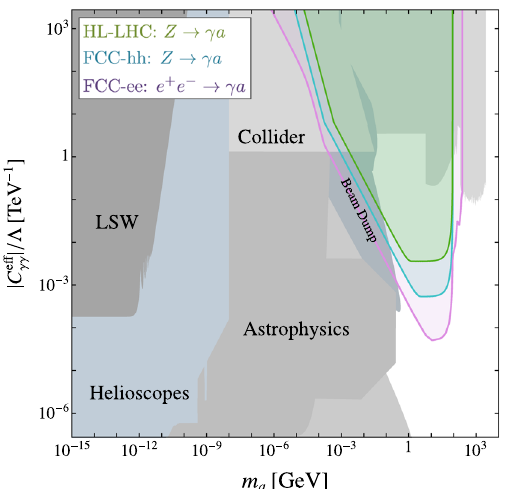
Fig. 12.5 Parameter regions which can be probed in the decay Z → γ a with a → γγ by the HL-LHC, FCC-ee, and FCC-hh. Figure adapted directly from [346]